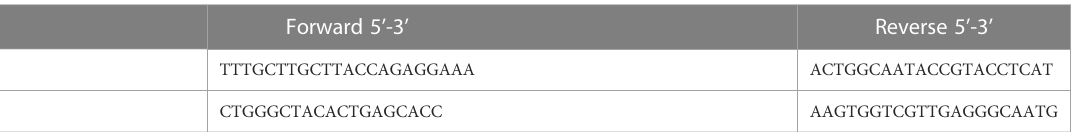
TABLE 1 qPCR primer